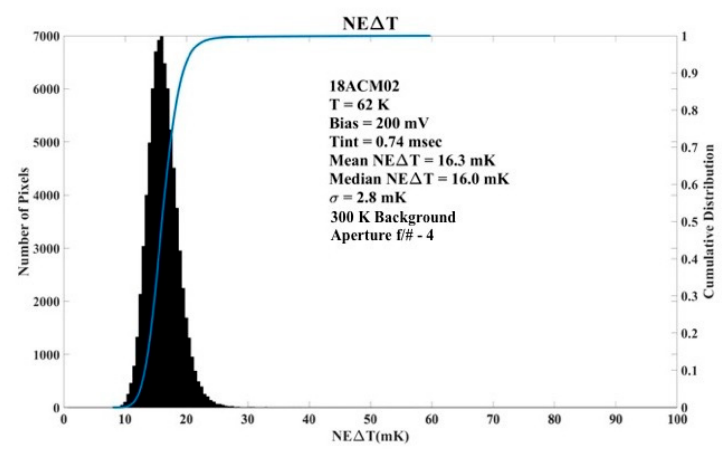
Figure 2. Noise equivalent temperature difference (NE Δ T) of the 12.5 μ m cutoff BIRD FPA at 62